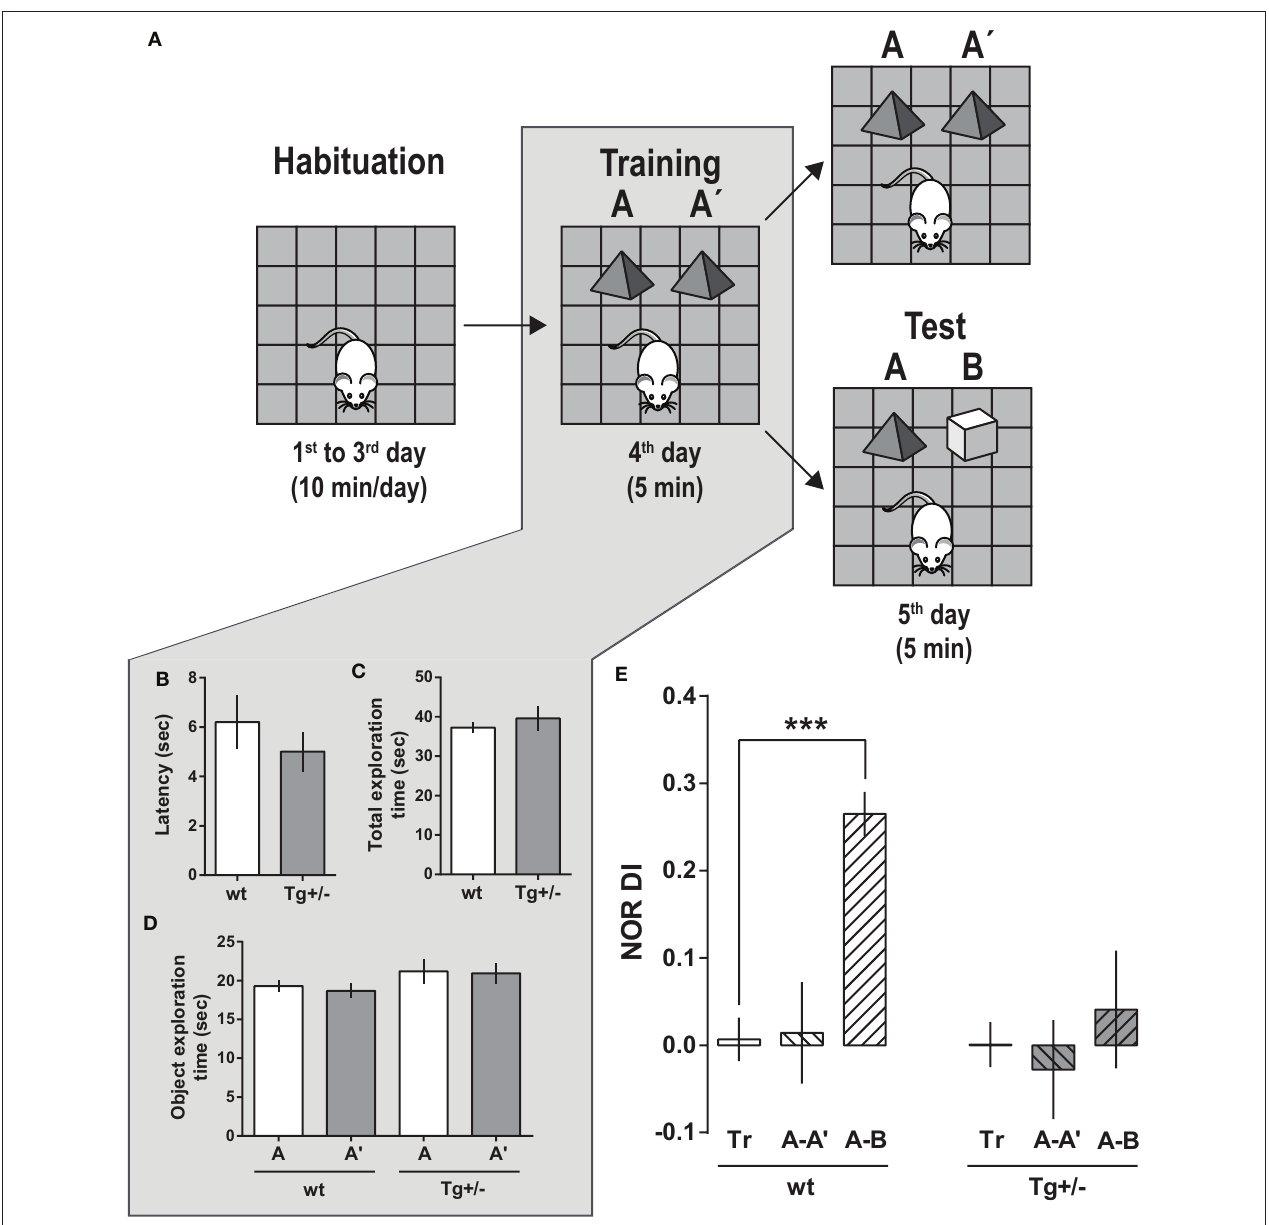
FIGURE 3 | Novel object recognition (NOR) task performance by 4-month-old McGill-R-Thy1-APP Tg + /– rats (A) Schematic representation of the task steps. Habituation: Rats were left to freely explore an OF for habituation to the environment (10 min/session, along 3 days). Training (Tr): On the 4th day, each rat was left to re-explore the OF in the presence of two identical objects (A–A ′ ), for 5min. Test (Te): On the 5th day, trained rats were split in two groups: Rats from one group were exposed for 5min to the same two objects (A–A ′ ) (as internal control at 24h), while rats from the other group, to a familiar and a novel object (A, B). (B) Training. Latency to start exploring an object. Bars represent latencies as mean ± SEM for each group. There were no significant differences between Tg + /– (dark gray bars, N Tg + / − = 19) and wt (white bars, N wt = 16) rats (Student’s t -Test). (C) Training. Total time spent exploring objects (A + A ′ ) by Tg/ + - and wt rats during the 5min Tr session. No significant differences were found between groups (Student’s t -Test). (D) Training. Time spent exploring each object (A or A ′ ). There were no significant differences when comparing the time spent exploring A and A ′ (Paired- t -test). (E) Test. On the 5th day, when tested in the presence of a novel (B) and a familiar (A) object (A-B, striped-bars), wt rats showed a significantly higher Discrimination Index in the Test session: [DI Te (A-B) = (time exploring B - time exploring A)/(time exploring B + time exploring A ) ] , compared to the Discrimination Index of Training [DI Tr (A-A ′ ) = (time exploring A ′ - time exploring A)/(time exploring A ′ + time exploring A)] (plain bars) or against zero. At variance, DI Te (A-B) for Tg + /– rats was similar to DI Tr (A-A ′ )—and it was not significantly different from zero. The two other groups of Tg + /– and wt rats were tested with same objects (A-A ′ ) used in the Tr session, as an internal control after 24h of Tr. In this case, the DI Te (A-A ′ ) for Tg + /– as well as that for wt rats were similar to the respective DI Tr . One-way ANOVA, Dunnett post-hoc test; *** P < 0.001 [N wt Te (A-A ′ ) = 8; N wt Te (A-B) = 8; N Tg + / − Te (A-A ′ ) = 9; N Tg + / − Te (A-B) =